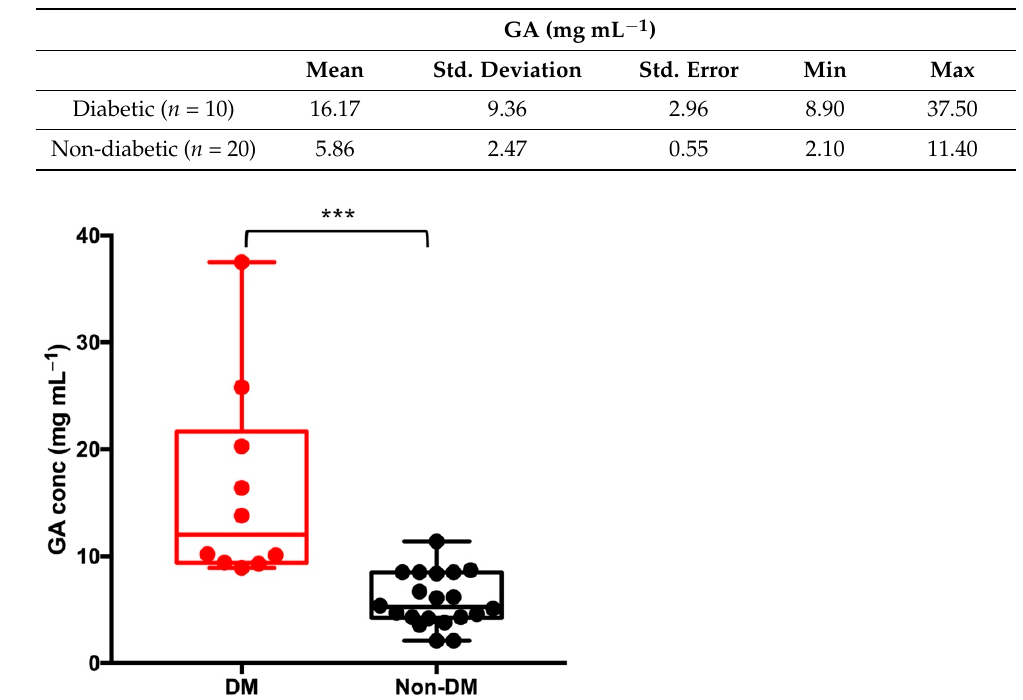
Table 3. Descriptive statistics table showing different concentrations of GA in diabetic and non- diabetic sera.